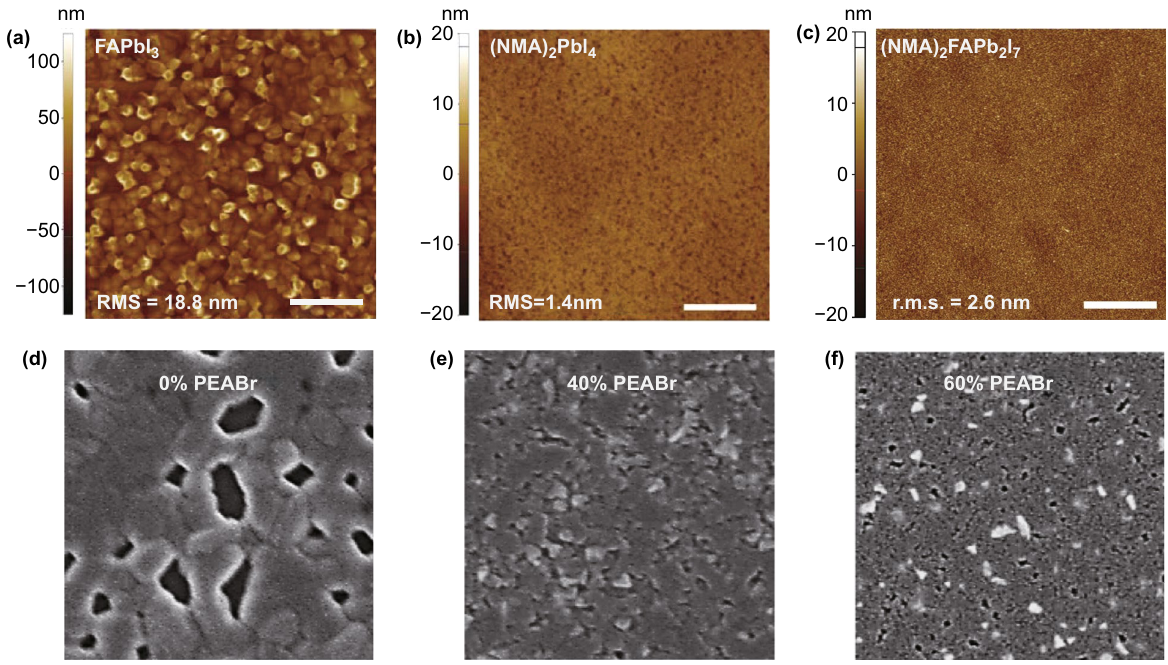
Fig. 5 AFM height images of a FAPbI 3 b (NMA) 2 PbI 4 and c (NMA) 2 FAPb 2 I 7 films (scale bar 5 μm). Copyright 2016 Springer Nature [42]. SEM images of perovskite films with d 0% PEABr e 40% PEABr and f 60% PEABr. Copyright 2019 Springer Nature